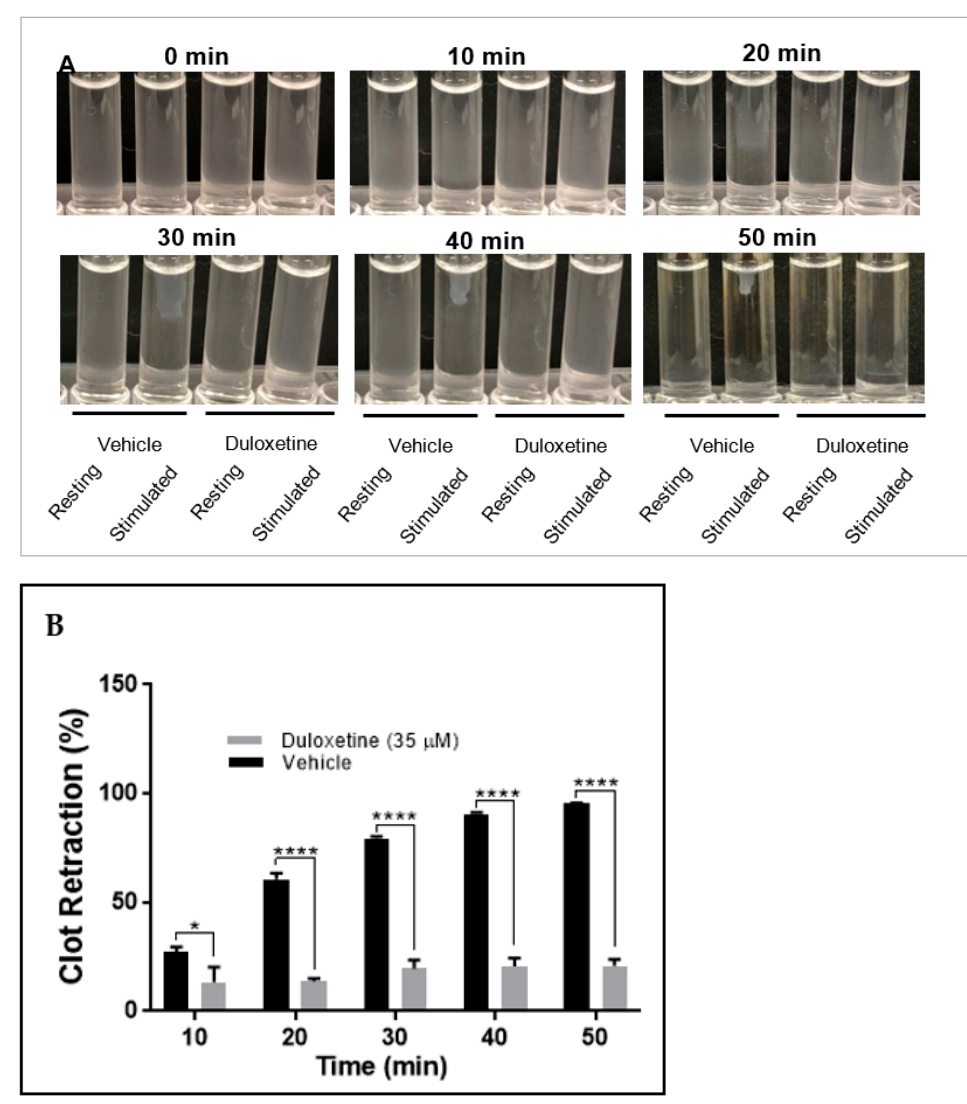
Figure 5. Duloxetine blocks clot retraction. Washed human platelets were isolated and incubated with either duloxetine (35 µ M) or the vehicle for 1 min and transferred to a glass cuvettes. Clot retraction was initiated by adding thrombin (0.1 U/mL), and monitored over time, with images taken via a digital camera every 10 min ( A ). Data quantification is shown in panel ( B ). This experiment was repeated three times, using blood obtained from three different healthy human subjects. The results were compared by running the student t -test using GraphPad Prism (* p < 0.05; **** p < 0.0001).